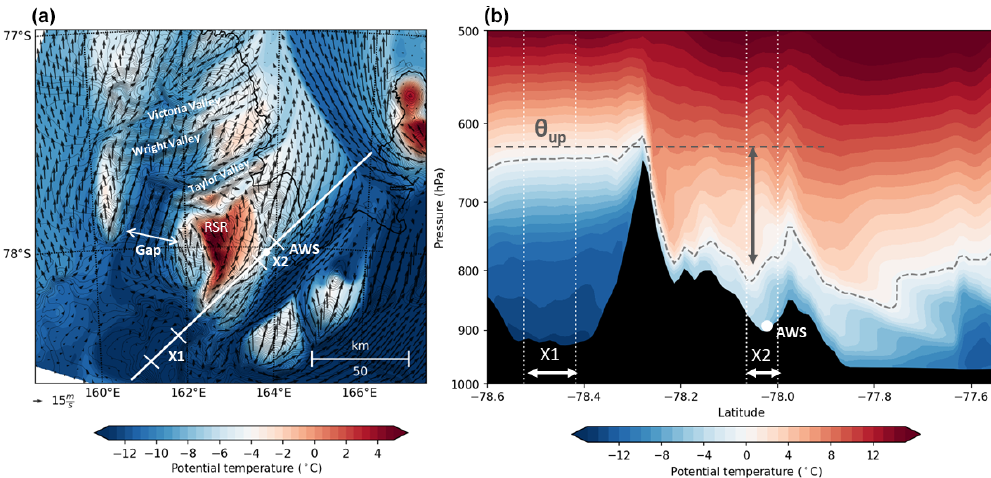
Figure 2. Foehn event on 12 April 2009 within (a) AMPS forecast of potential temperature at lowest model level (arrows show the 10m winds, and RSR indicates the Royal Society Range) and (b) AMPS forecast of vertical potential temperature profile across the transect shown in (a) . X1 indicates the upwind region of undisturbed flow; X2 is the region over Joyce Glacier; θ up the potential temperature at mountain height level over X1 that is used to measure the isentropic